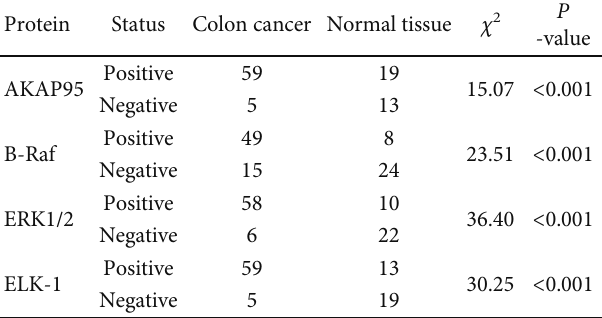
Table 1: AKAP95, ERK1/2, ELK-1, and B-Raf protein levels in colon cancer and normal